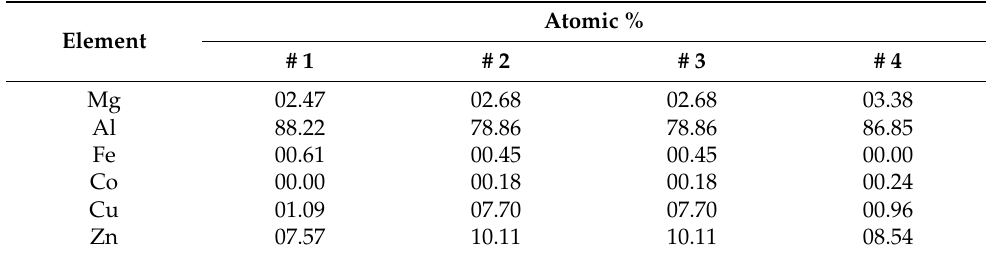
Figure 3. EDX elemental mapping of SPSed AA7075 in area indicated by red square in Figure 2a: aluminium ( a ); magne- sium ( b ); zinc ( c ); copper ( d ); transverse cross-sectional BF-TEM micrographs ( e , f ). Insets of Figure 3e,f present CBED pattern of second phases.